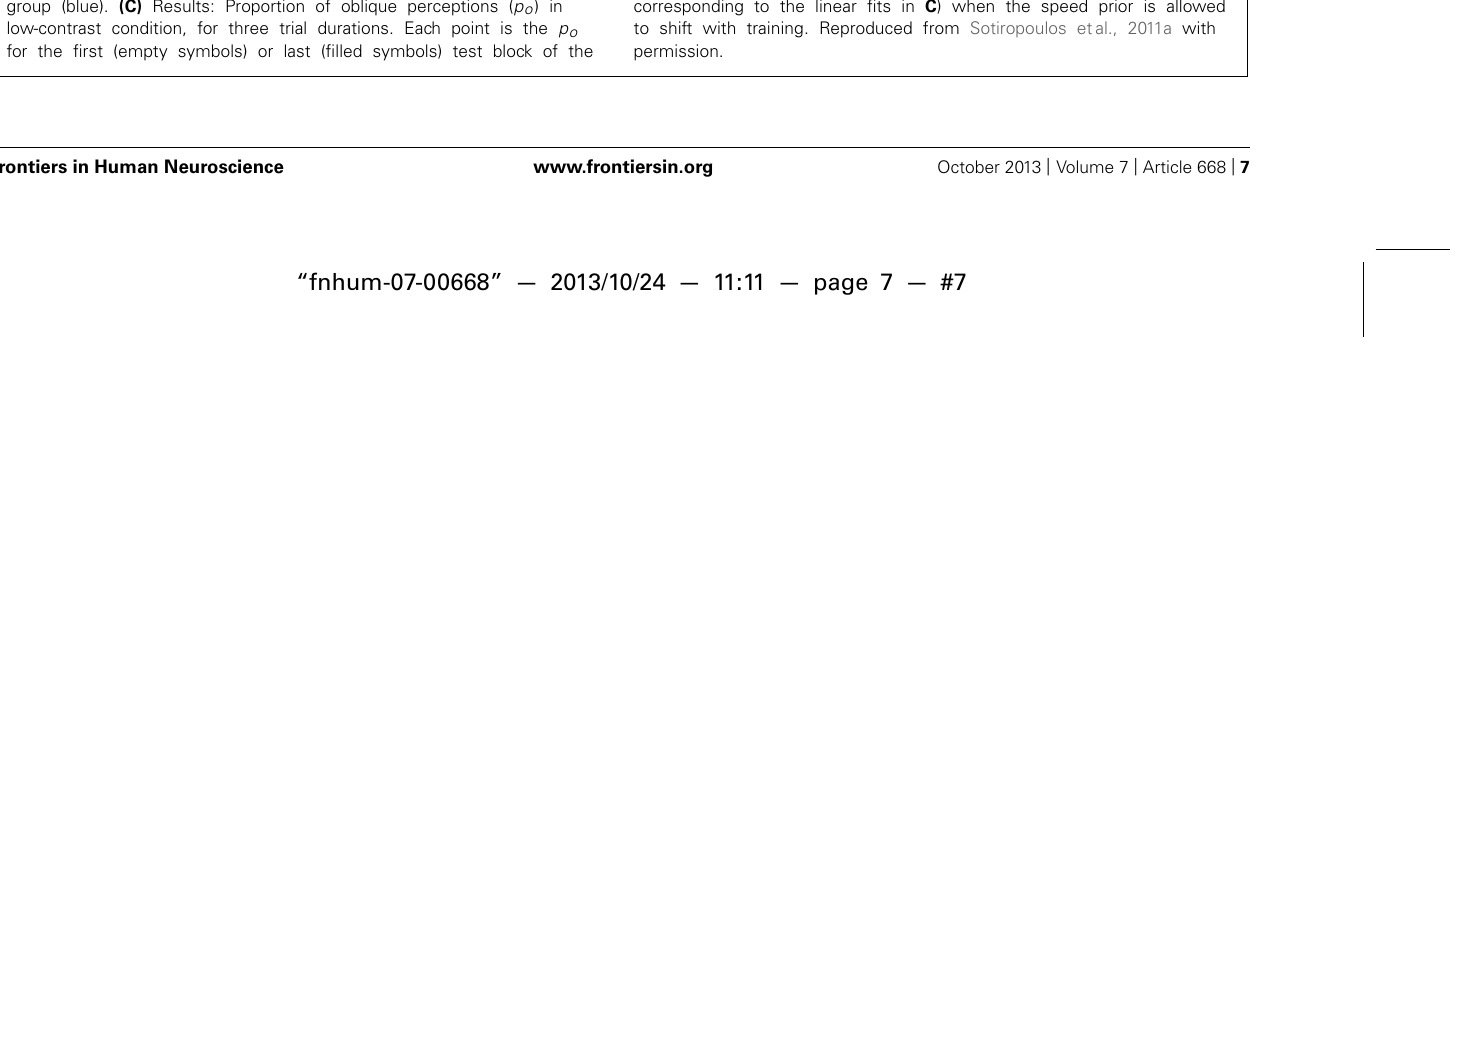
session, for the high-speed (red) or the low-speed (blue) group. Lines correspond to linear fits to each block/group combination. Error bars denote between-subjects SEM. Initially participants are biased toward perceiving motion as being more often perpendicular to the orientation of the lines than it really is (consistent with estimating that the test stimulus is slower than it really is). However, this bias slowly decreases with training in the experimental group, and reverses after 3 days (consistent with estimating that the test stimulus is faster than it really is). (D) Fits from Bayesian model of motion perception (points) can account for the behavior of the two groups (lines, corresponding to the linear fits in C ) when the speed prior is allowed to shift with training. Reproduced from Sotiropoulos etal., 2011a with